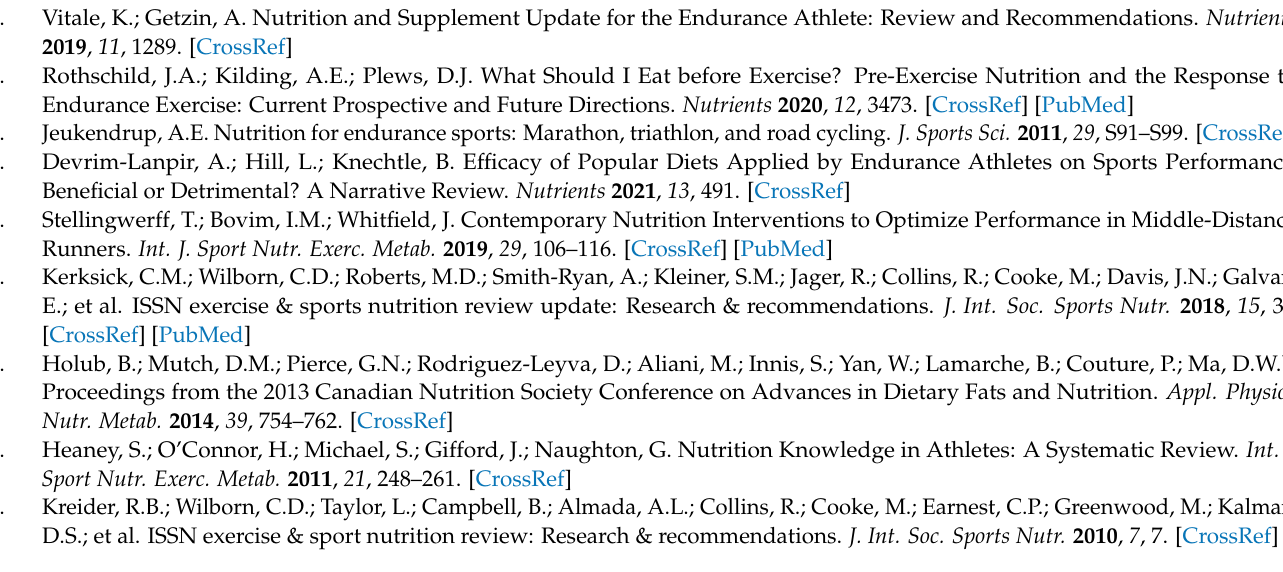
Supplementary Figure S3: Funnel plot of the effect of CT combined with LCHF on body fat percentage to controls; Supplementary Figure S4: (A) Forest plot of the effect of CT combined with LCHF on body mass in recreationally trained or professionally trained participants; (B) Forest plot of the effect of intervention duration ( ≤ 6 weeks or >6 weeks) on body mass; Supplementary Figure S5: Funnel plot of the effect of CT combined with LCHF on body mass; Supplementary Figure S6: Funnel plot of the effect of CT combined with LCHF on VO2max; Supplementary Figure S7: (A) Forest plot of the effect of CT combined with LCHF on aerobic performance in recreationally trained or professionally trained participants; (B) Forest plot of the effect of intervention duration ( ≤ 6 weeks or >6 weeks) on aerobic performance; Supplementary Figure S8: Funnel plot of the effect of CT combined with LCHF on time (or distance) to complete the aerobic